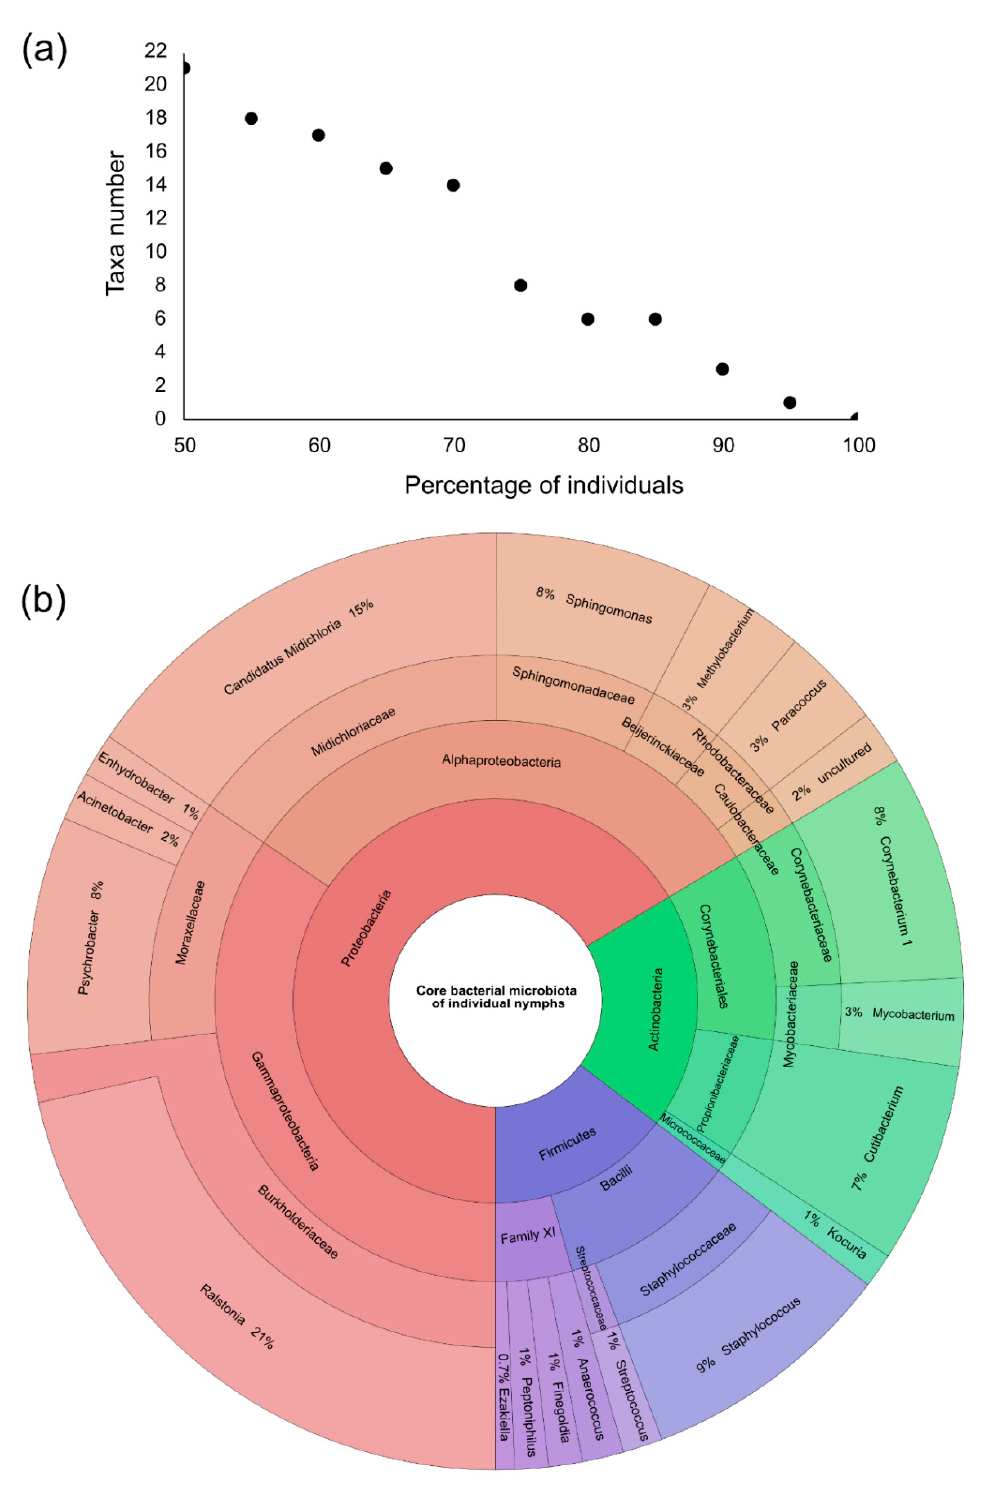
Figure 4. Core internal bacterial microbiota of individual nymphs. ( a ) The number of taxa present in nymphs. Each black dot represents the number of taxa present in the corresponding percentage of individuals. Twenty-one taxa were present in at least 50% of the collected individuals; ( b ) Krona chart representation showing the twenty-one taxa present in at least 50% of collected nymphs. These taxa represent the internal core microbiota at the individual level.